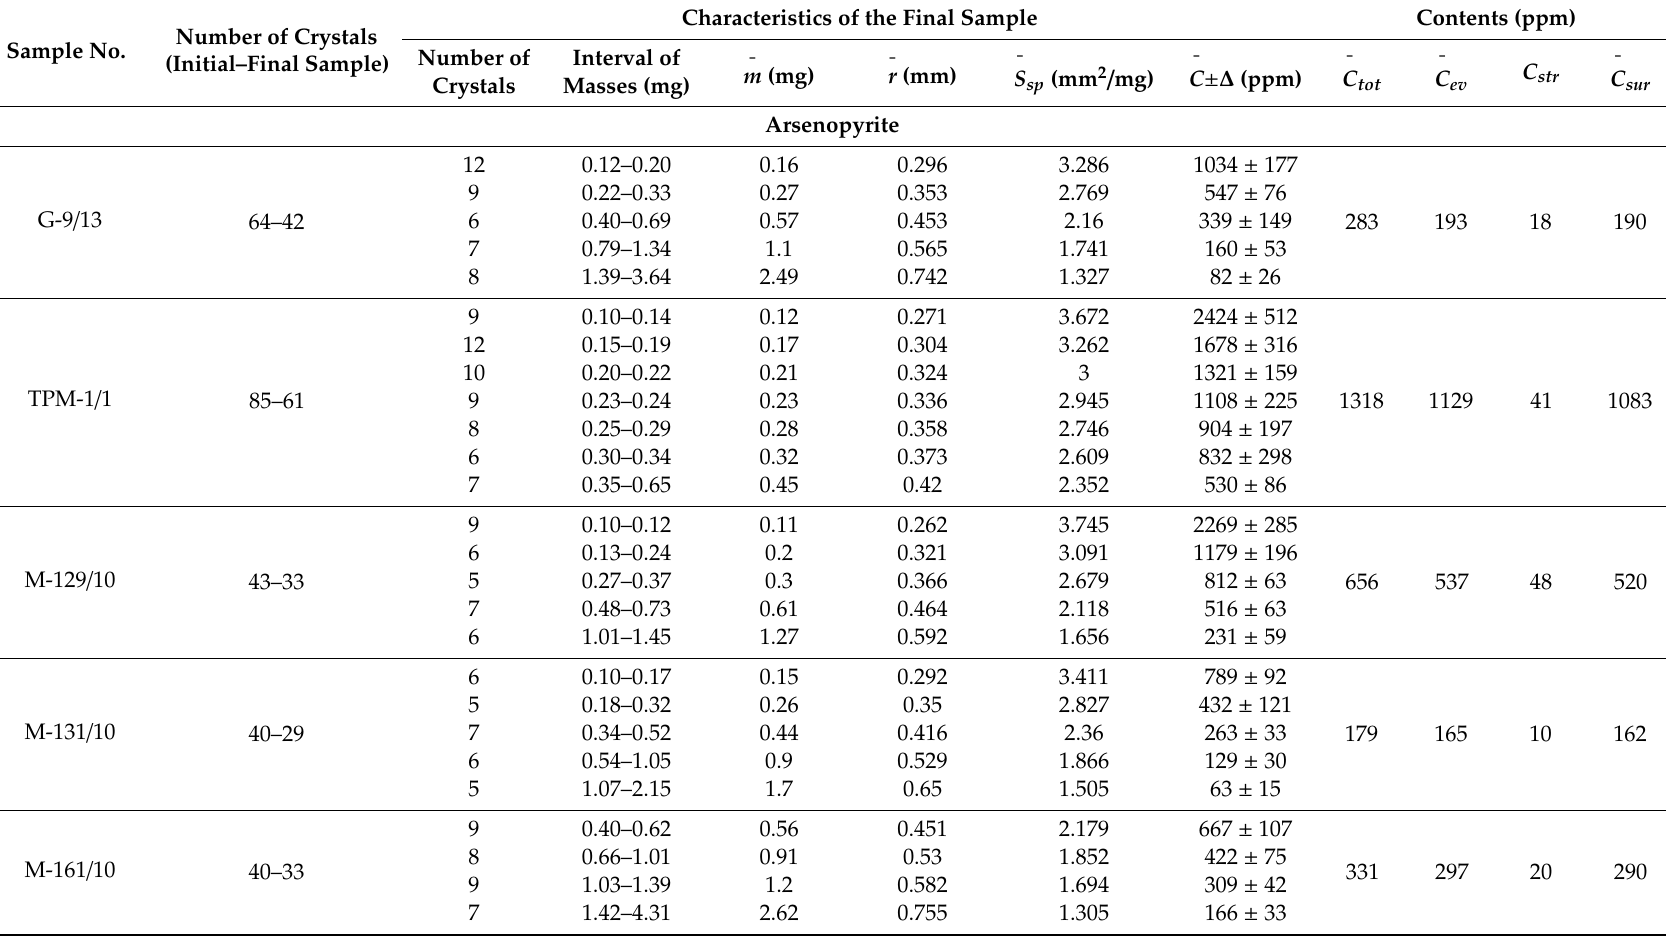
Table 5. Results of ruthenium analysis of single crystal size selections of arsenopyrite and pyrite from vein, streaky-vein and veinlet-disseminated ores of the Natalkinskoe